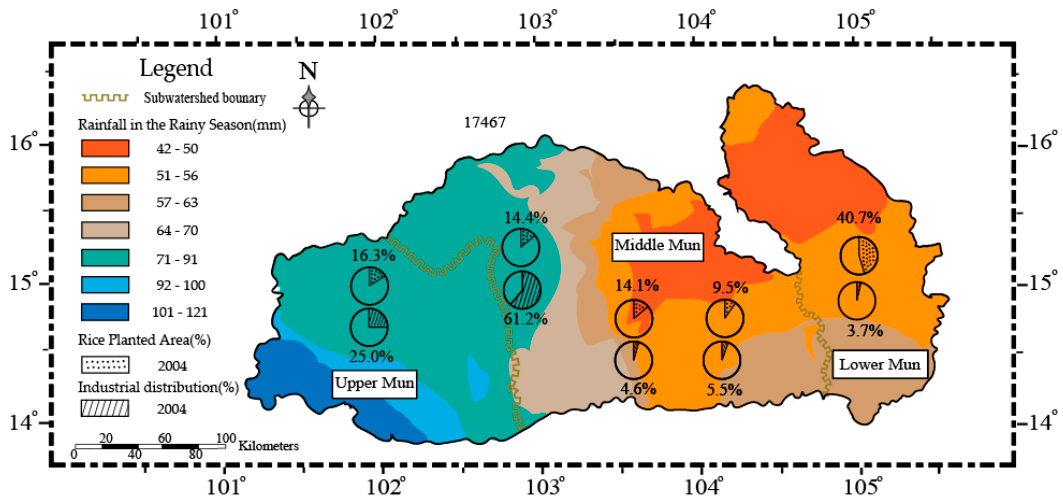
Figure 2. Spatial patterns of annual precipitation in the dry season and the distributions of industry and rice-planted areas. Precipitation data and land-use data are from previous studies [30,34].